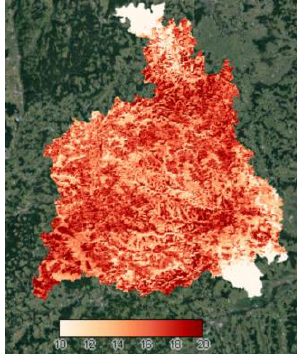
Figure 7: LST Stuttgart -